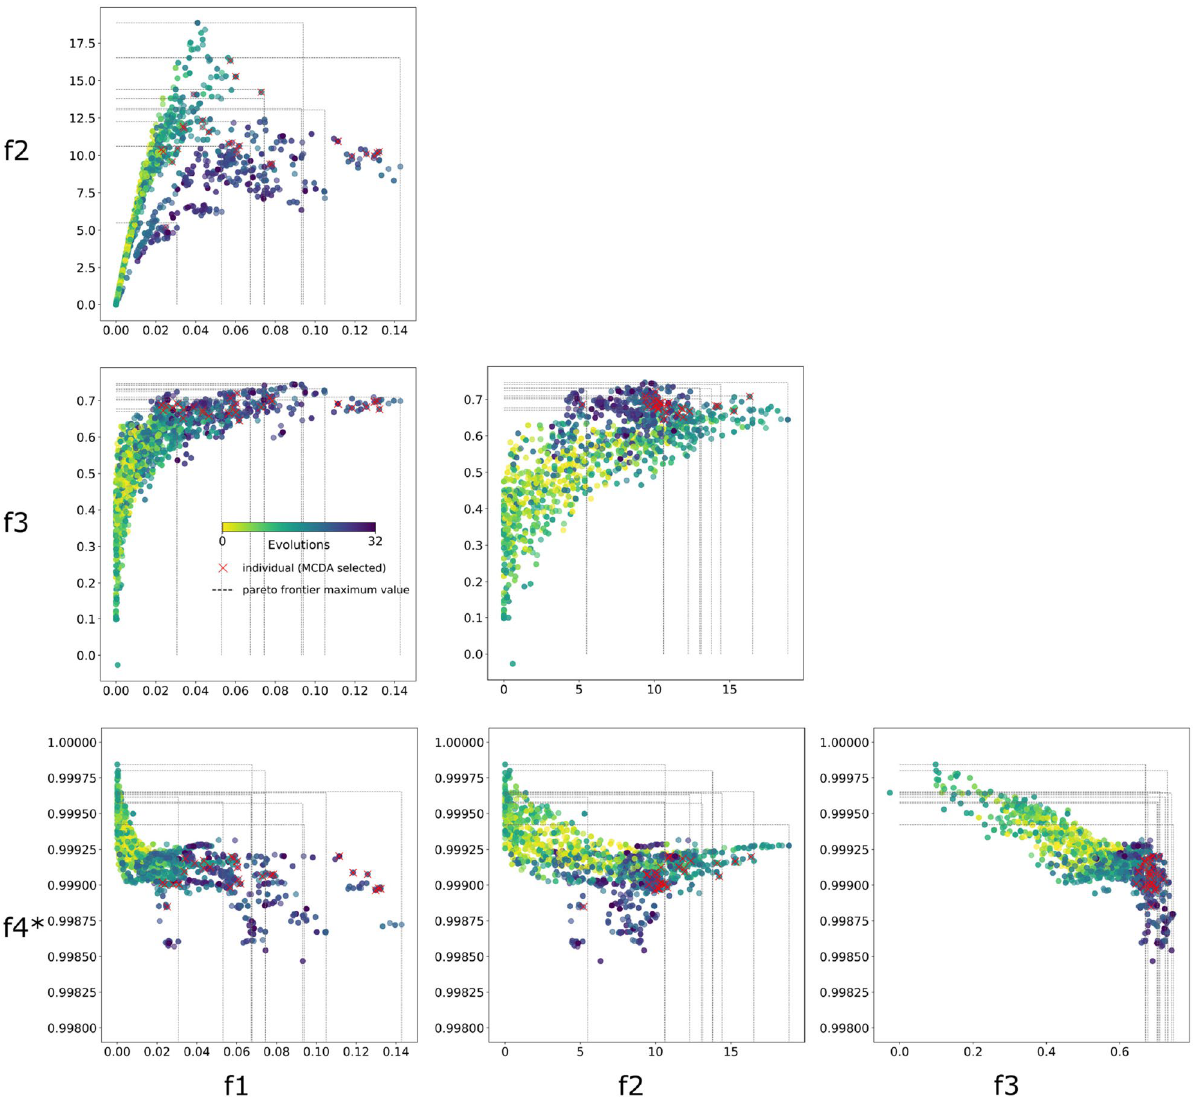
Figure 5. Objective function optimization for global tracking. Pair-wise visualization of the optimization of the four proposed objective functions: f 1 : distance-weighted coverage, f 2 : true/false positive rate, f 3 : projection coincidence, and f ∗ 4 : commissural passage. Our framework drives objectives toward the Pareto front in the upper-right direction. MCDA-based best objective trade-offs across brains are shown as red x markers. The standard setting is computed as their mean and standard deviation.